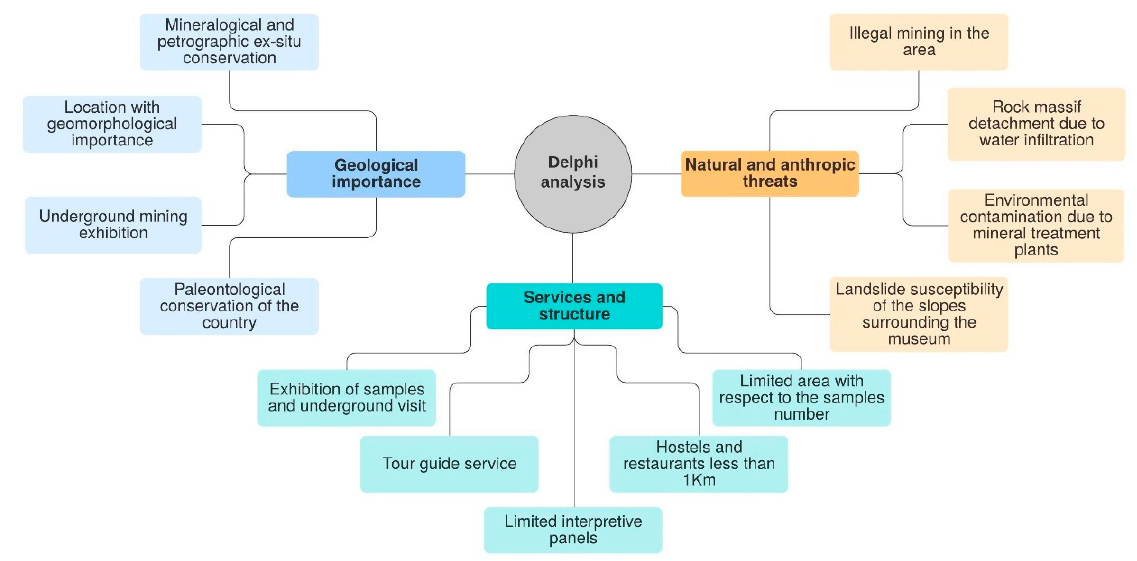
Figure 6. A summary scheme of the Delphi method’s results.